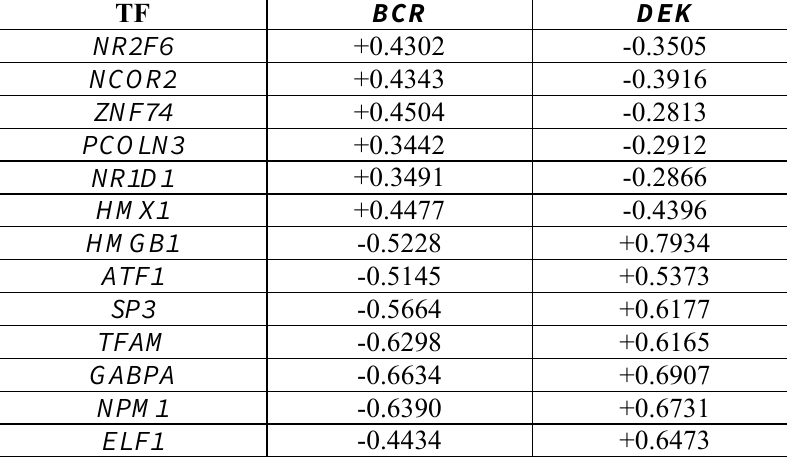
Table 6: Association analysis of BCR, and DEK with transcription factors in terms of regulation